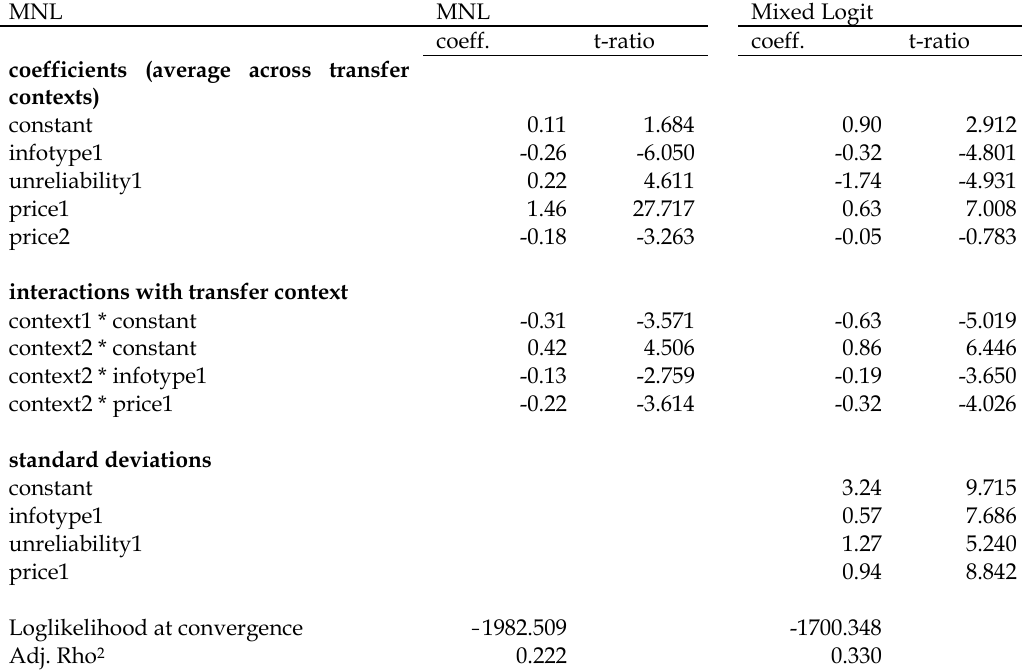
Table 4. Estimated coefficients of MNL and Mixed Logit